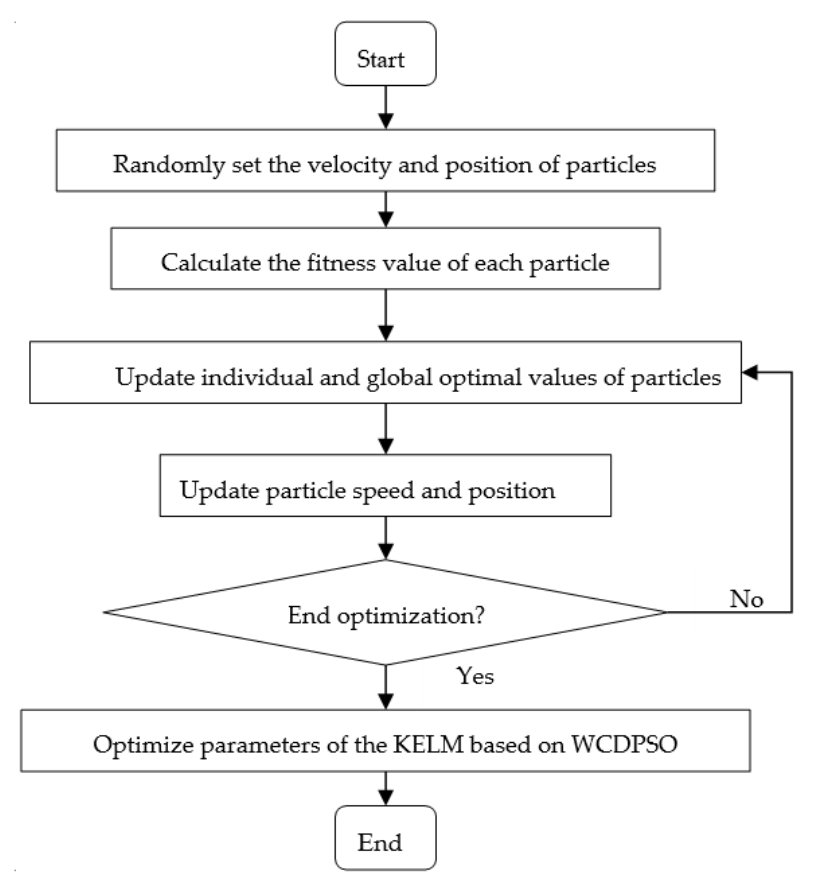
Figure 2. The flowchart of parameter combinatorial optimization based on WCDPSO.